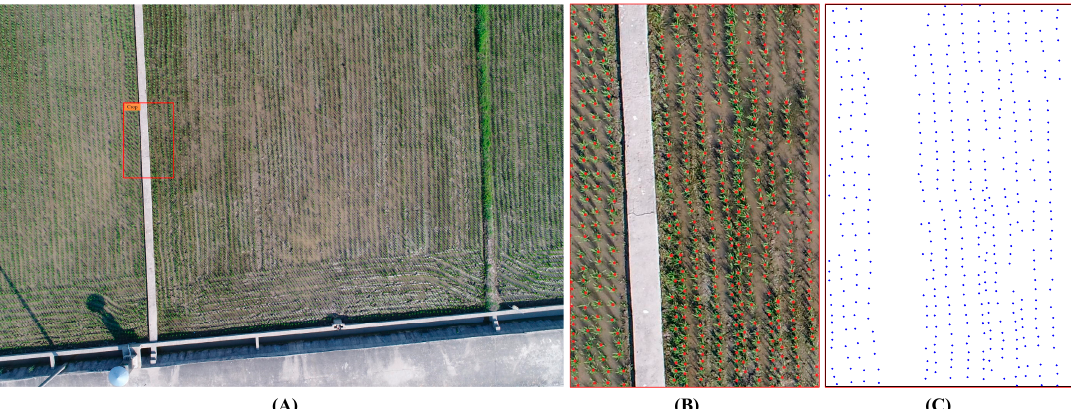
Figure 1. An example of the rice seedling annotations in the rice seedling counting (RSC) dataset: ( A ) raw unmanned aerial vehicle (UAV) image, ( B ) manually-annotated cropped image, and ( C ) exact positions of the rice seedlings.